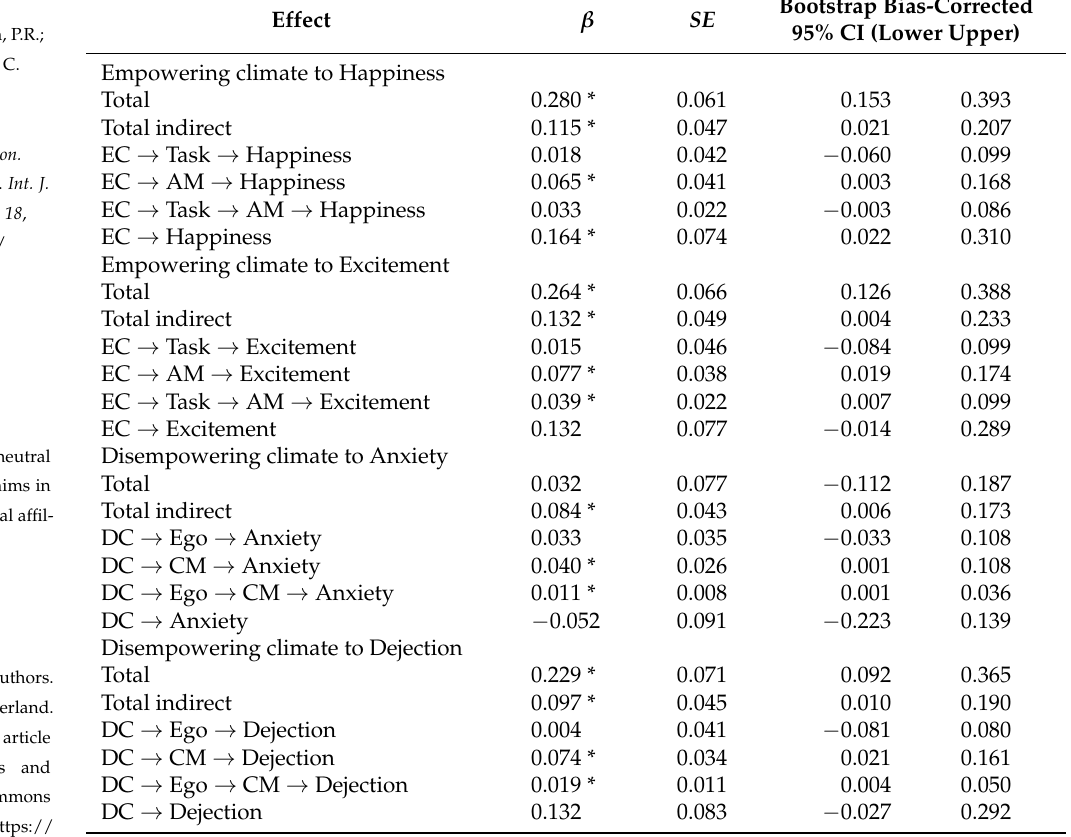
Table 3. Total, direct, and indirect effects for paths from empowering and disempowering climates to emotions via task- or ego-goal orientations, and autonomous or controlled